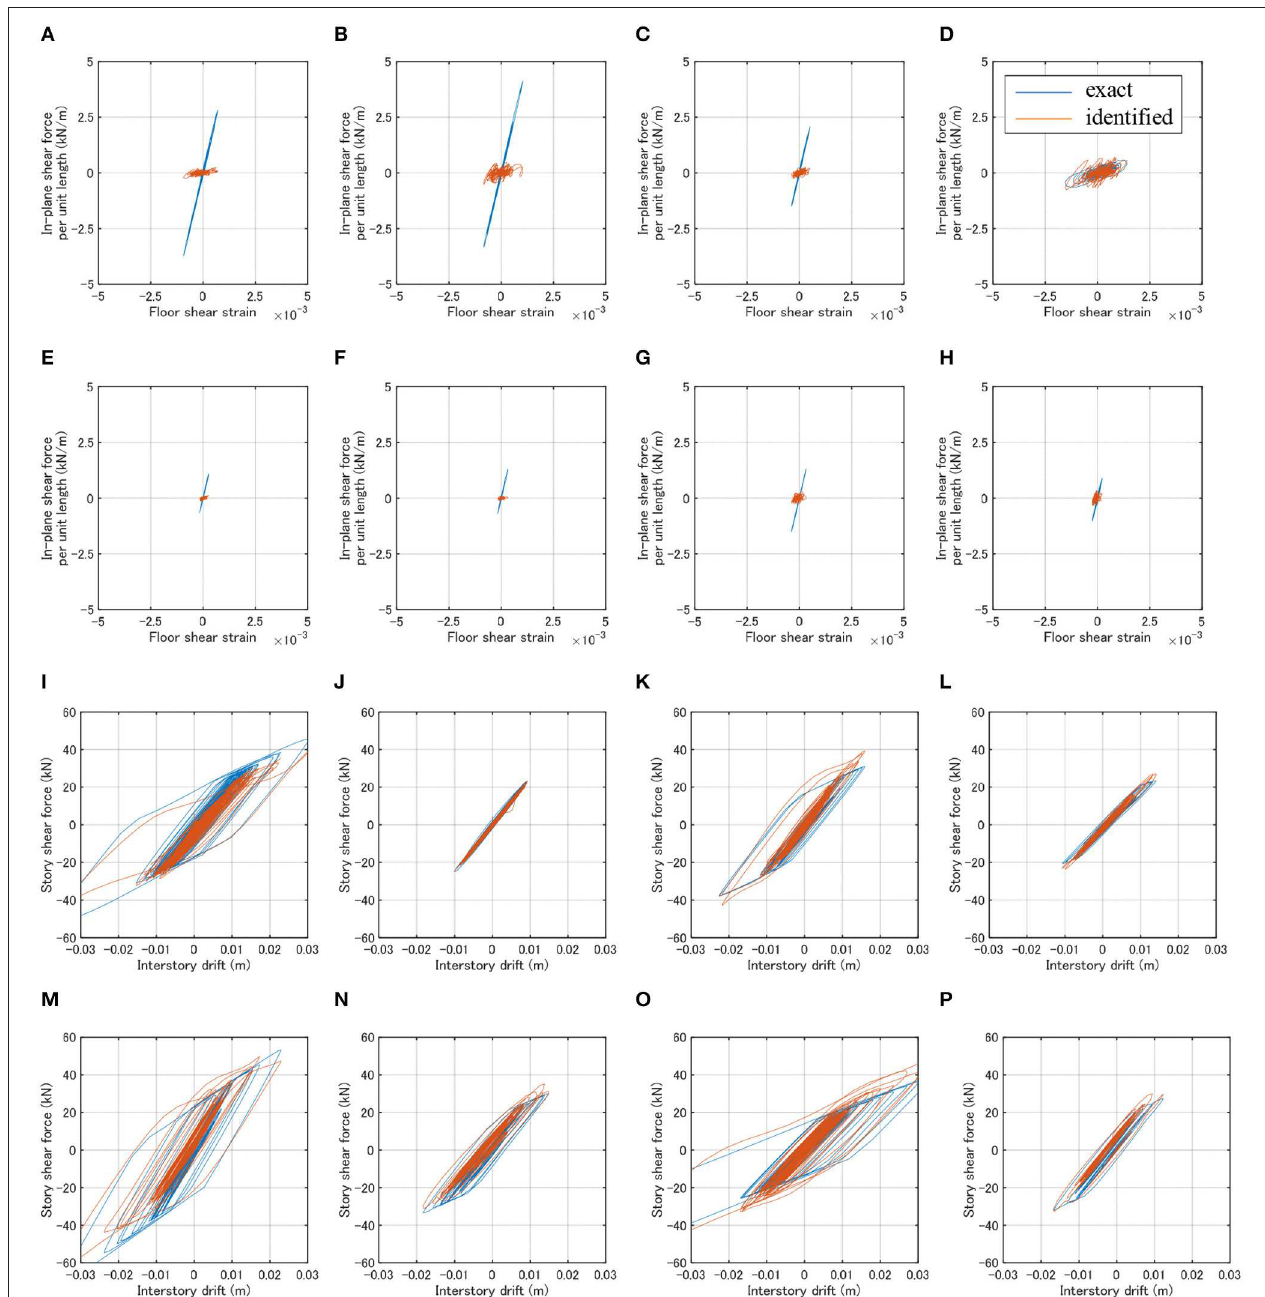
FIGURE 11 | Identification results for case of different floor stiffness (El Centro 1940 NS). (A) H-frame (x1y1_1F). (B) H-frame (x1y2_1F). (C) H-frame (x2y1_1F). (D) H-frame (x2y2_1F). (E) H-frame (x1y1_2F). (F) H-frame (x1y2_2F). (G) H-frame (x2y1_2F). (H) H-frame (x2y2_2F). (I) V-frame (x1_1F). (J) V-frame (x1_2F). (K)